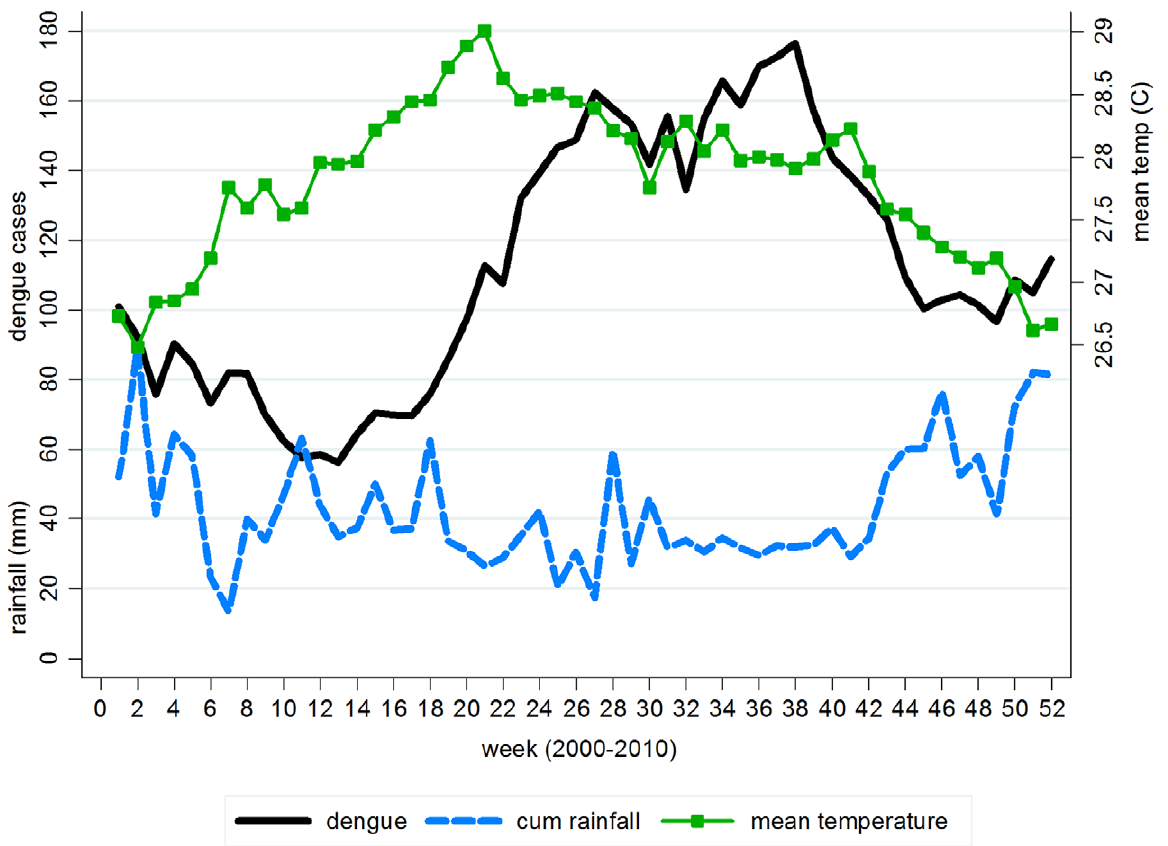
Figure 1. Average weekly distribution of dengue cases, mean temperature, and cumulative rainfall. Graphical presentation of lag relationship between weather predictors and dengue cases using weekly average over the period